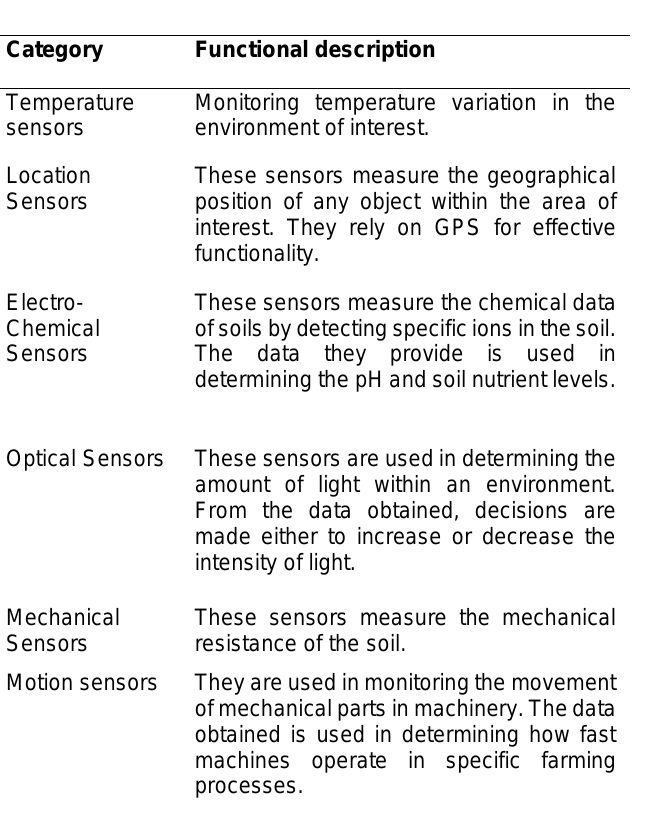
Table 1. Types of sensors for IoT application in agriculture